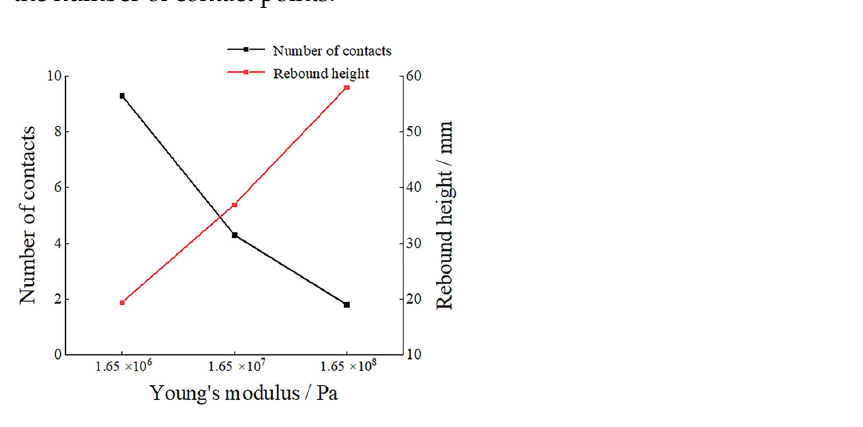
Figure 26. Relationship between the bounce height, the number of contacts and Young’s modulus.